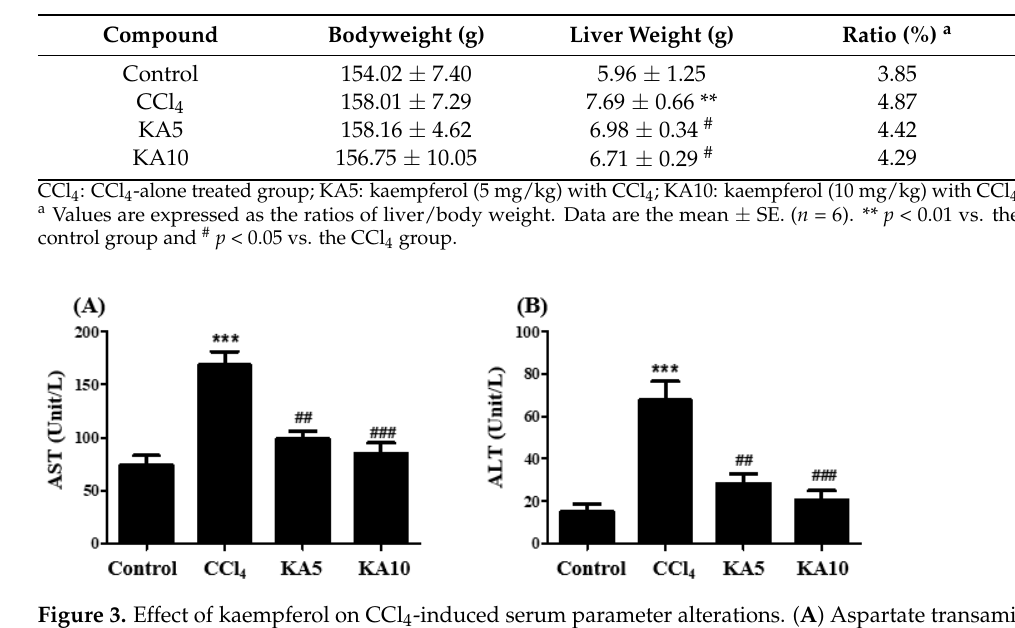
Figure 3. Effect of kaempferol on CCl 4 -induced serum parameter alterations. ( A ) Aspartate trans- aminase (AST); ( B ) Alanine transaminase (ALT). Groups are as described in “Materials and Meth- ods”. Values are mean ± SE ( n = 6). *** p < 0.001 vs. the control group, ## p < 0.01, and ### p < 0.001 vs. the CCl 4 group. 2.4. Liver Histopathology The effect of kaempferol on CCl 4 -induced histopathological alterations in the liver was evaluated by examining Hematoxylin and Eosin (H&E)-stained liver sections. The typical lobular architecture with central veins and radiating hepatic cords was disrupted, and there was sub-massive necrosis, vacuolization, and macrovesicular fatty changes in hepatocytes of CCl 4 -intoxicated rats (Figure 4B). However, the administration of